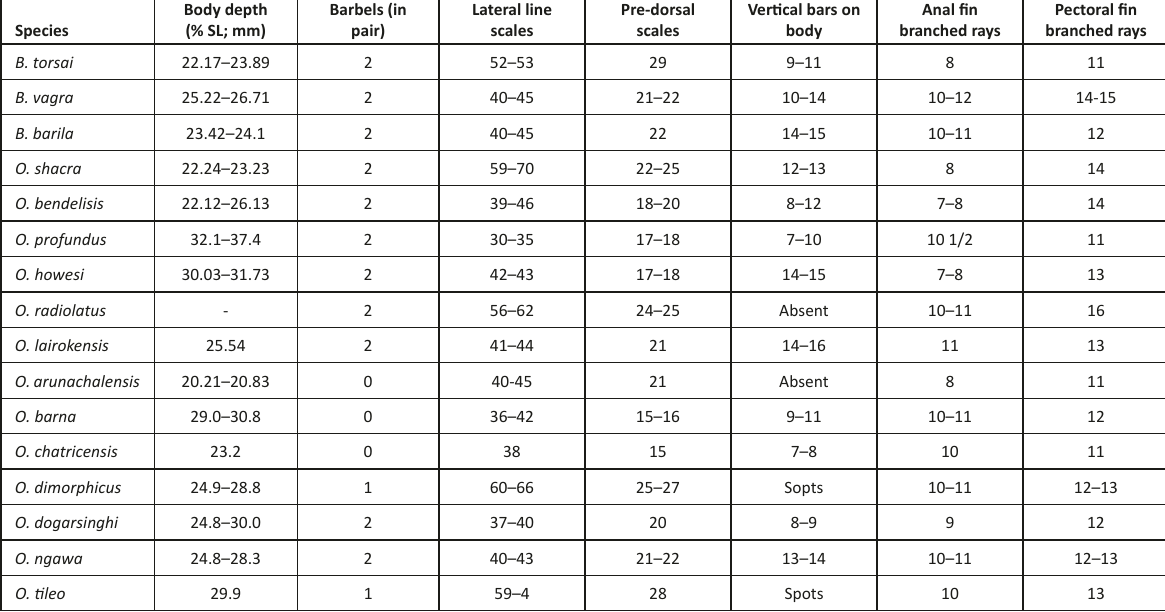
Table 2. Comparative measurements of body depth, vertical bars on body and meristic counts of Barilius torsai sp. nov. with related species of Barilius and Opsarius . Species